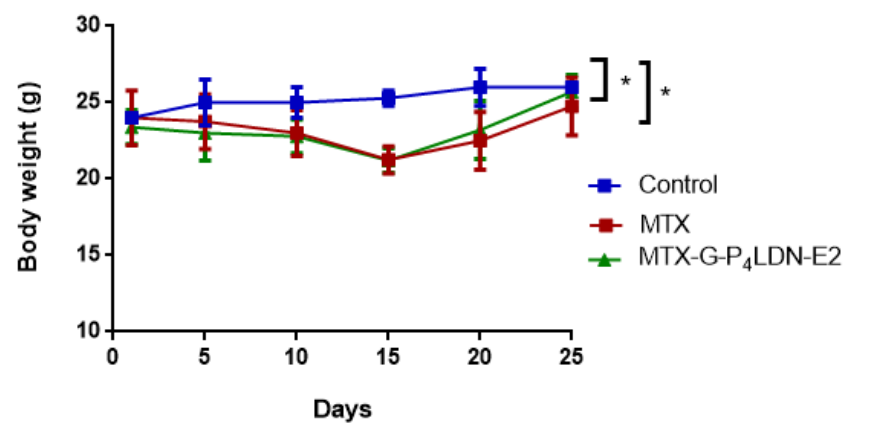
Figure 9. Effect of tumor treatment on body weight in female NOD-SCID mice ( n = 3 for control group, n = 6 for MTX, and n = 6 for MTX–G–P 4 LDN–E2). The data are represented as the arithmetic mean ± SD. Statistical analysis was performed using one-way ANOVA followed by Dunnett’s test (* p < 0.05 between control and treatment groups).